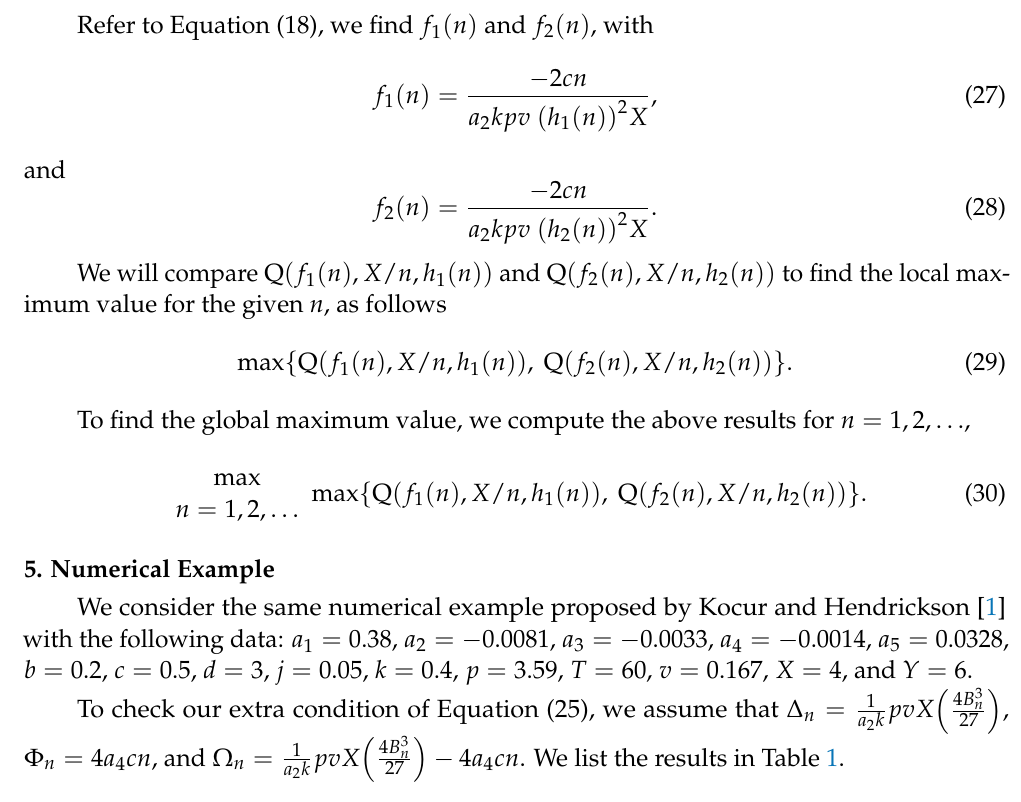
Table 1. Numerical examination for our extra